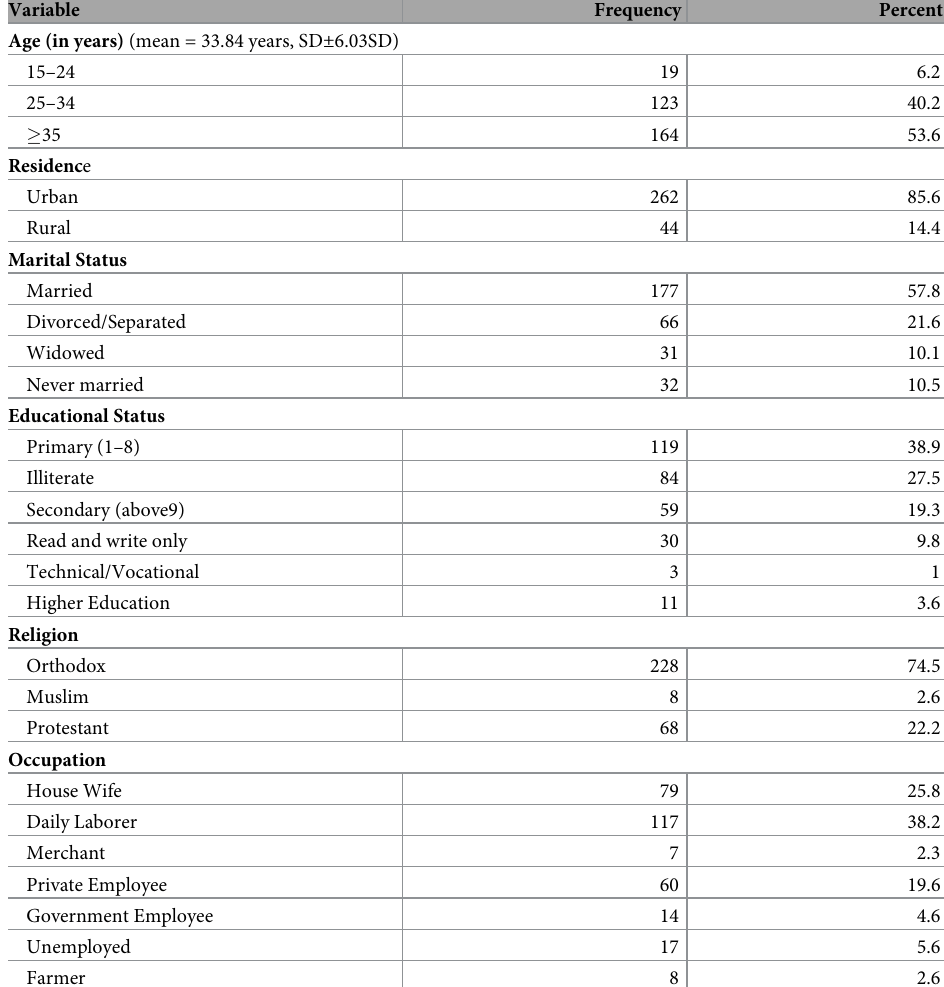
Table 1. Socio-demographic characteristics of HIV positive women in chronic care in Bishoftu Town Health insti- tution, 2020 (n = 306). Variable